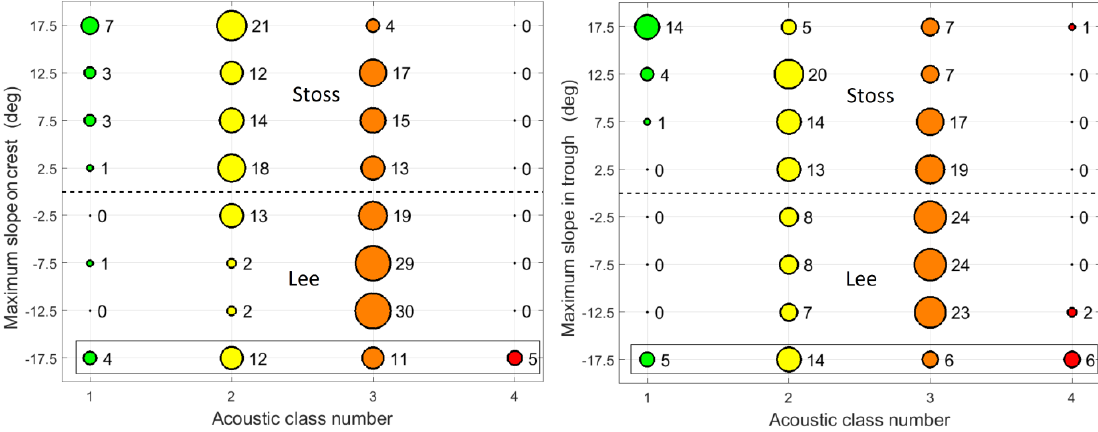
Figure 18. Acoustic classification results of 32 typical areas with megaripple structure given for bin centers ranging from –17.5 to 17.5 degrees; crest ( left ), trough ( right